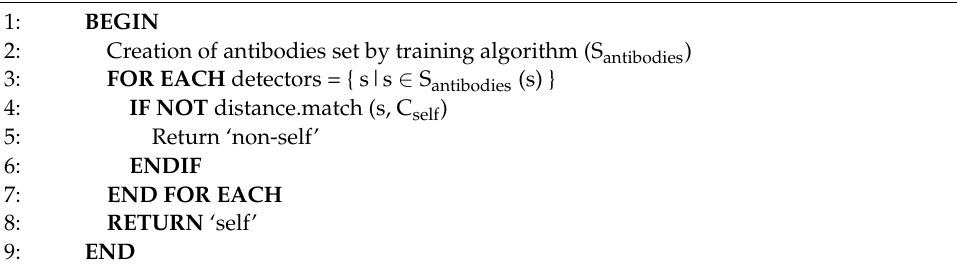
Algorithm 2. Pseudo Code for artificial immune system (AIS)